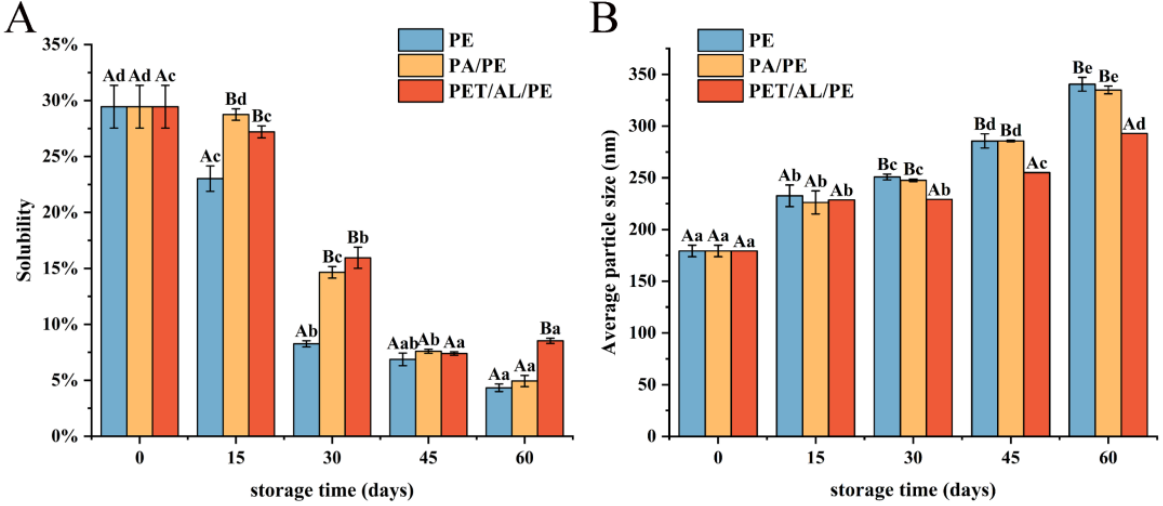
Figure 5. Effects of packaging materials on solubility ( A ) and particle size ( B ) of walnut protein isolate. In the figures, capital letters represent the differences among package materials in each storage period, lower letters show differences among storage periods in each package at p < 0.05 error level according to Duncan’s multiple range test. The error bar represents the standard error of the mean value.